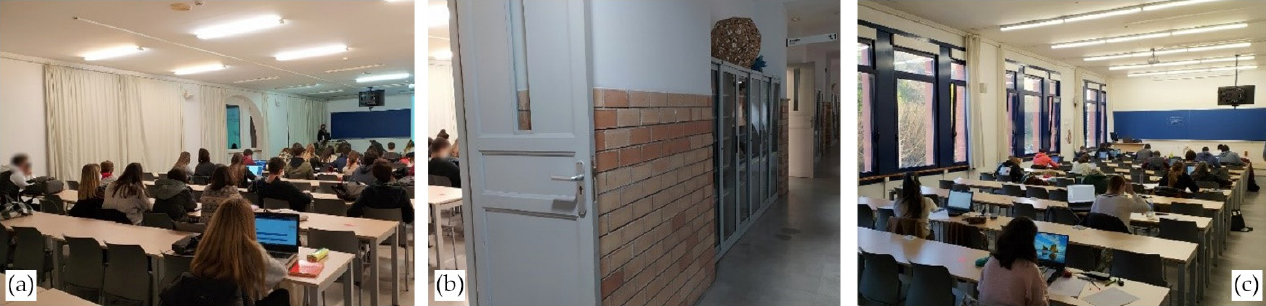
Figure 10. State of the classrooms during lessons in Phase I. ( a ) and ( b ) show room with door open but ventilation partially restricted to darken for projection and presentation purposes. In picture ( c ) a typical lecture in class A 2.1 with tilted windows can be seen. Source: authors.